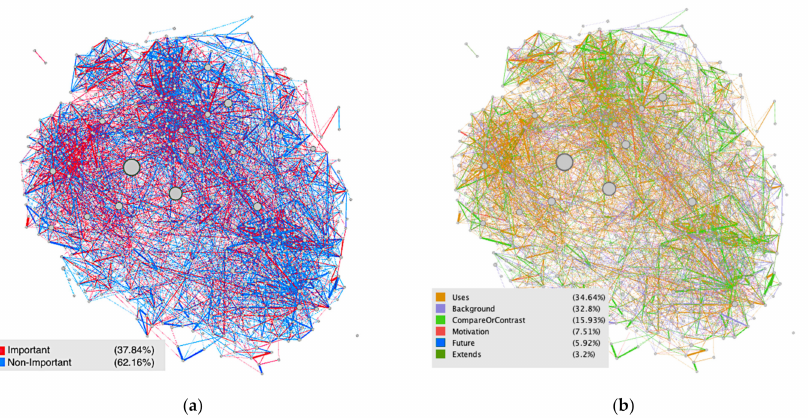
Figure 5. Visualization of the ACL ARC citations network to only visualize the citation classes: ( a ) presents the binary class citations edges and ( b ) illustrates the multi-class citation edges between the nodes. The top 1% of total nodes with respect to the node degree are taken to visualize the citations network. We used the OpenOrd layout in Gephi to see these citations